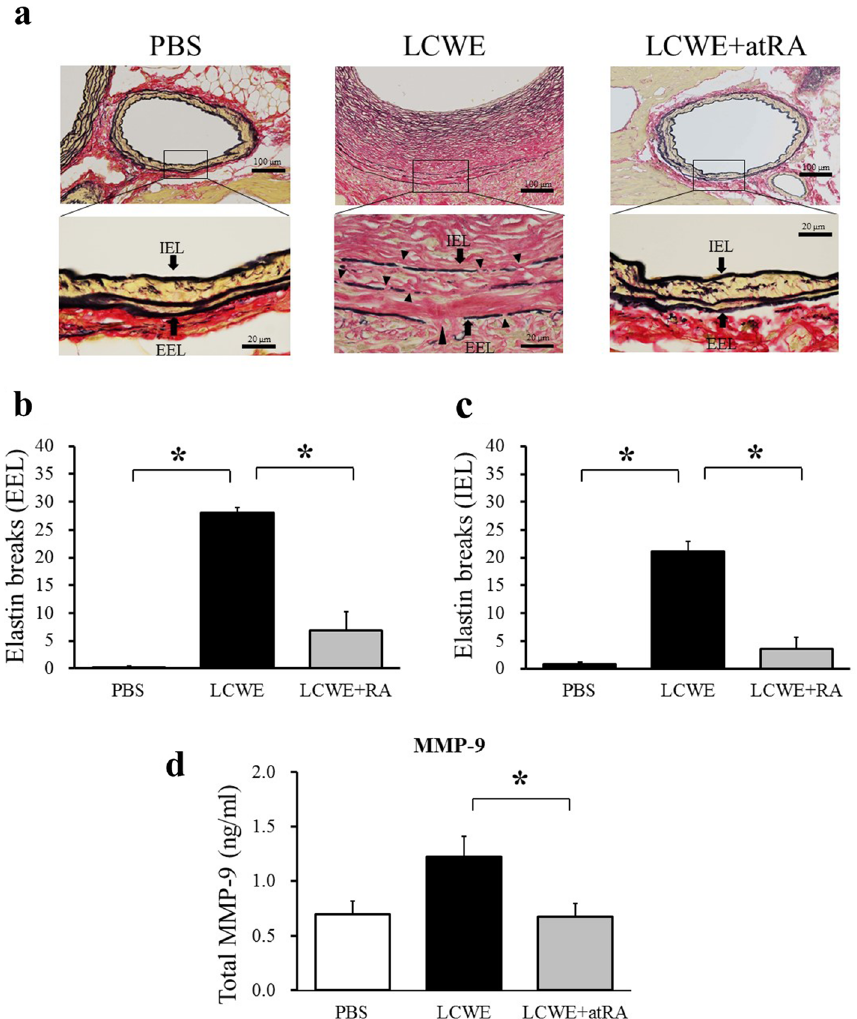
Figure 5. Effect of atRA on LCWE-induced elastin breaks. EVG staining of CAs from mice treated with PBS, LCWE and LCWE + atRA (a) . Elastin breaks in the external elastic lumina (EEL) (b) and in the internal elastic lumina (IEL) (c) among the groups (PBS: n = 5, LCWE: n = 6, LCWE + atRA: n = 7). (d) The serum level of MMP-9 in mice with PBS (n = 5), LCWE (n = 6) and LCWE + atRA (n = 7). The data are expressed as the mean ± SD. *p < 0.0001, **p < 0.05. All the data were generated from 1 experiment at the same